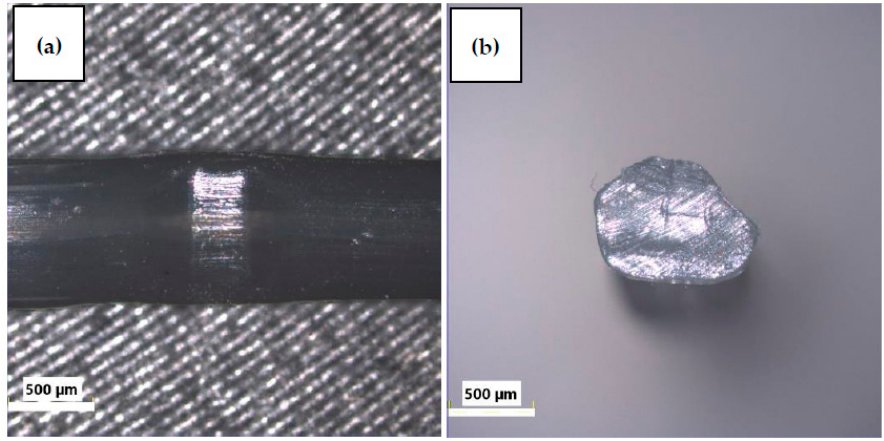
Figure 6. Light microscope images of PPG (Olympus): ( a ) surface, ( b ) cross-section [55].